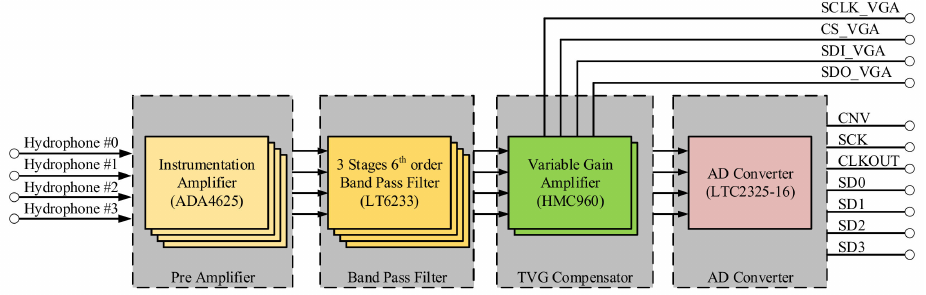
Figure 8. Acquisition module hardware block